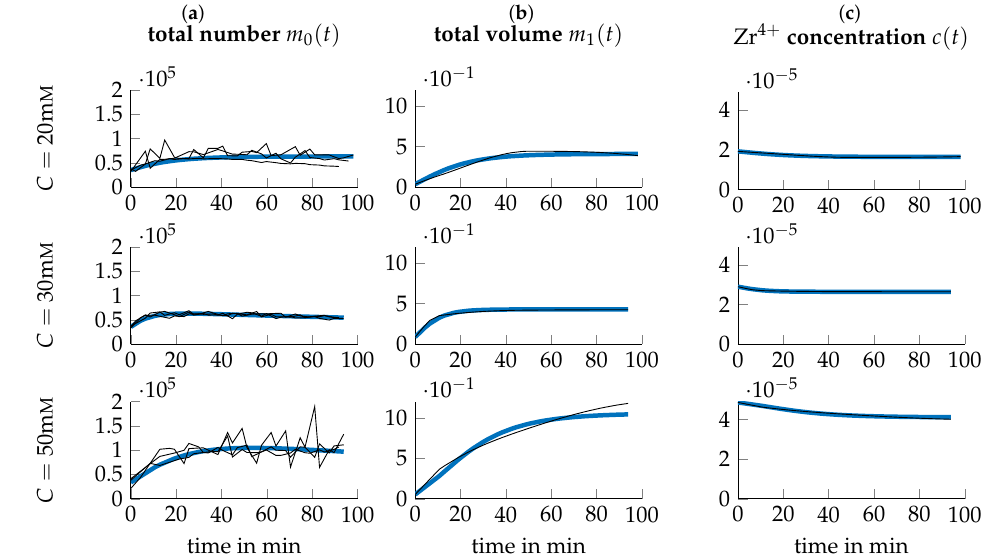
Figure 1. Data (black thin lines) and simulation (blue thick lines) for T = 25 ◦ C and different precursor concentrations C . The time-series of the data are calculated according to Section 3.3 from the temporal evolutions of the average particle diameter of the particle population obtained from a single DLS run and the average concentration of Zr 4 + obtained from three independent ICP measurements. The three black lines correspond to three independent DLS runs.